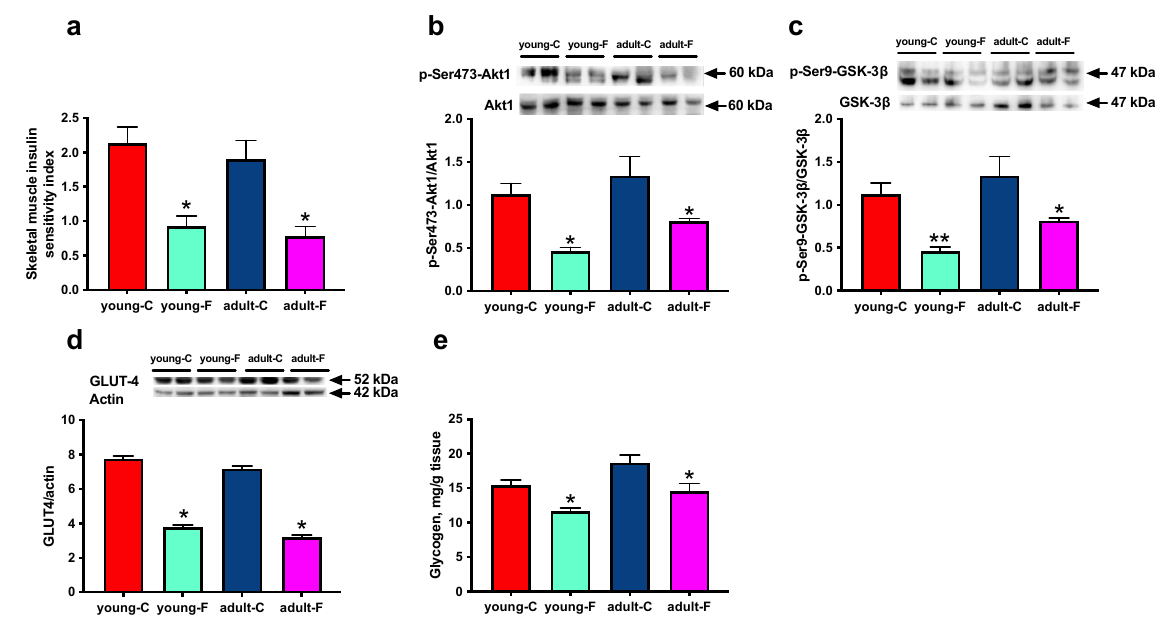
Figure 1. Skeletal muscle insulin signalling. ( a ) Skeletal muscle insulin sensitivity index, Western blot quantification (with representative Western blots) of ( b ) p-Akt, ( c ) p-GSK, ( d ) glucose trans- porter 4 (GLUT-4) and ( e ) content of glycogen in skeletal muscle in young and adult rats fed a con- trol (young-C and adult-C) or fructose-rich diet (young-F and adult-F) for 2 weeks. Values are the means ± SEM of eight different rats. * p < 0.05, ** p < 0.01 compared to respective controls (two-way ANOVA followed by Tukey post-test).